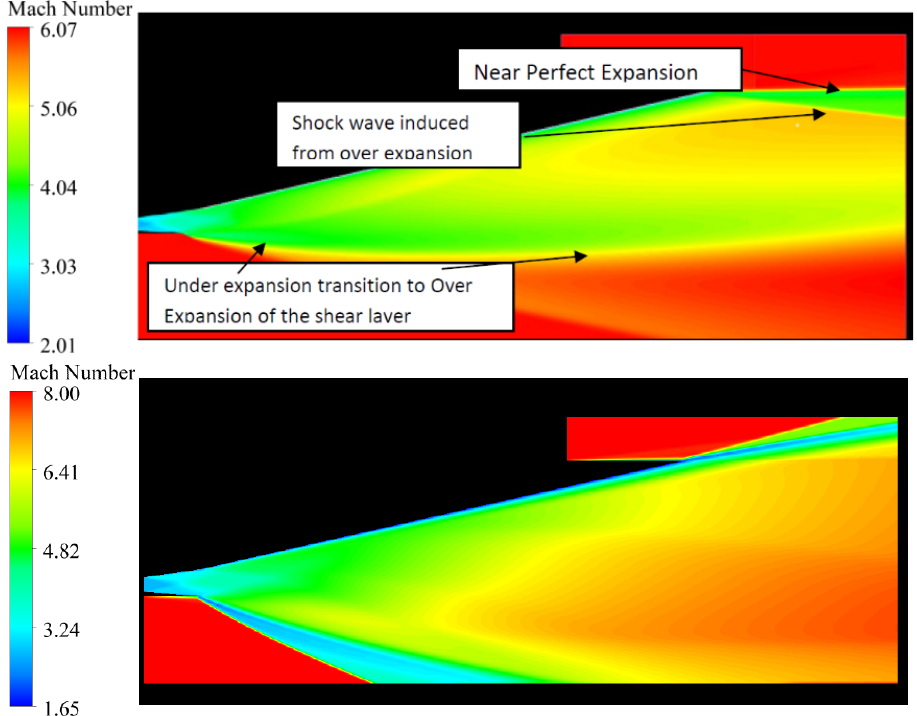
Figure 10. Contours of Mach number for DP 351 at BCC 1.1 ( top ) and BCC 3.2 ( bottom ).